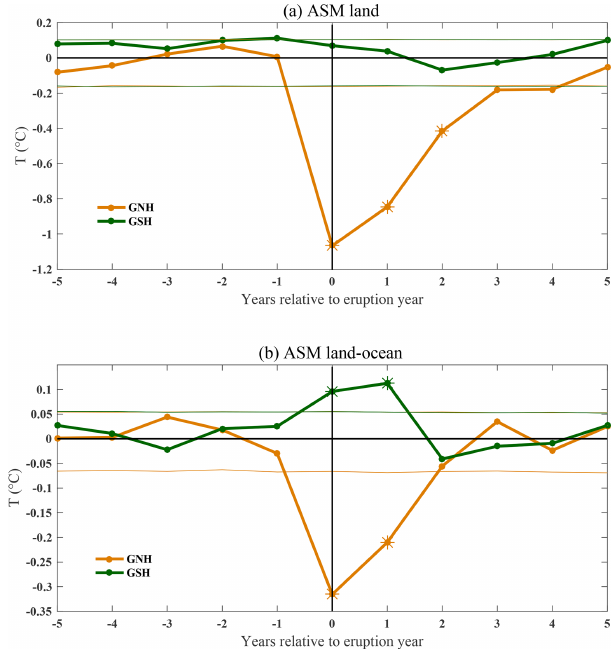
Figure 5. Temporal SEA results of the summer (JJA) mean tem- perature ( ◦ C) of land (a) and the difference between land and ocean (b) in the Asian monsoon region (land and ocean part is 8.75 ◦ S– 56.25 ◦ N, 61.25–143.75 ◦ E). The thinner lines stand for the relative Monte Carlo model results at the 95% confidence level. The as- terisks represent the years that passed the Monte Carlo model tests at the 99% confidence level. Year 0 represents the eruption year identified by the volcanic-forcing index, while negative and posi- tive years represent relative years before and after the